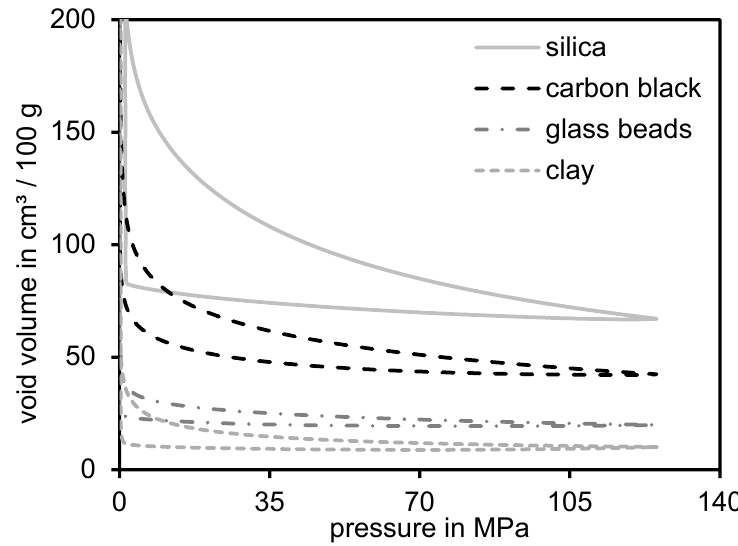
Figure 8. Four different structured materials measured by means of the void volume structure tester . Figure 8. Four di ff erent structured materials measured by means of the void volume structure